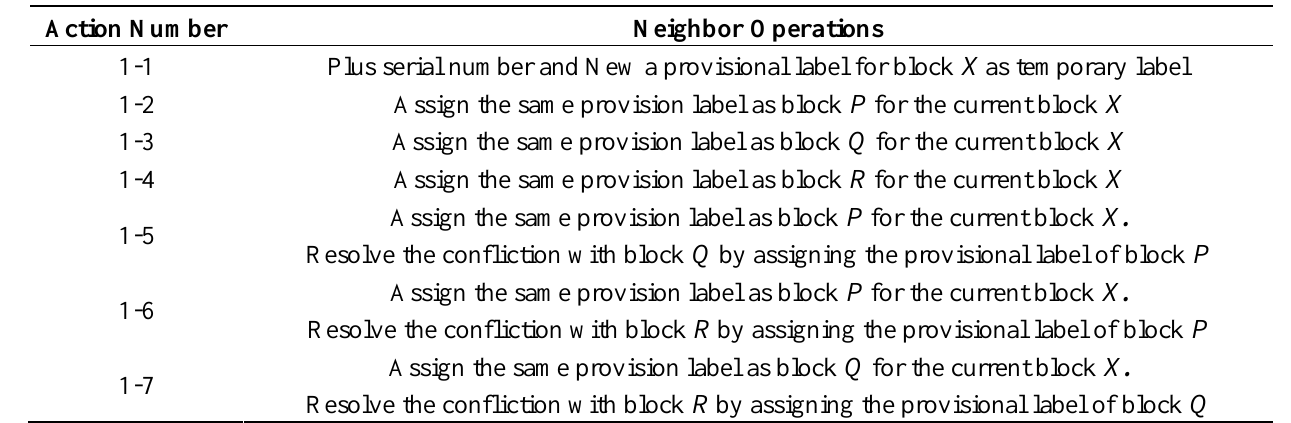
Table 1. Actions of procedure